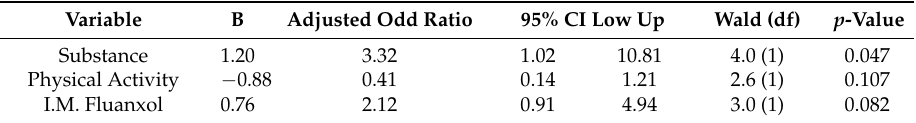
Table 5. Multiple logistic regression analysis of comorbidity of substance abuse, physical activity, and fluanxol depot with metabolic syndrome in patients with